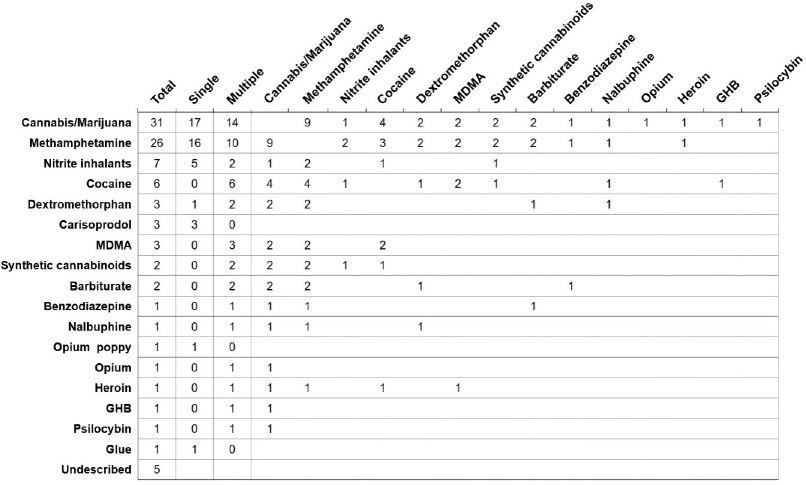
Fig 2. Cross-chart showing drug preferences among specific drugs in patients reported to use multiple types of drugs in their lifetime. MDMA, 3,4-methyl enedioxy methamphetamine; GHB, gamma hydroxybutyrate.